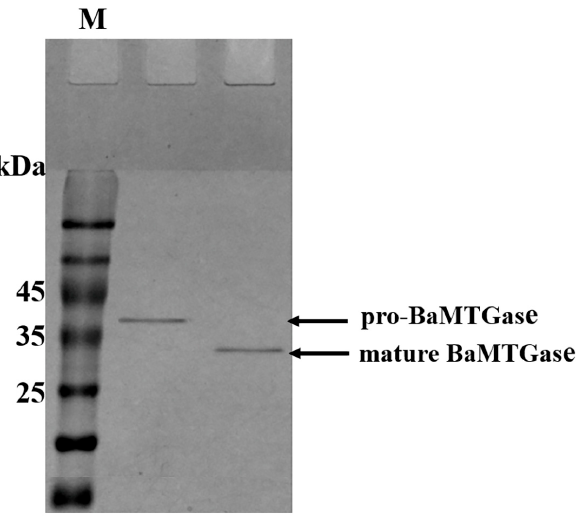
Figure 2. Proteolysis of SPUsp45-pro-BaMTGase with trypsin to achieve mature BaMTGase. M: molecular weight marker.